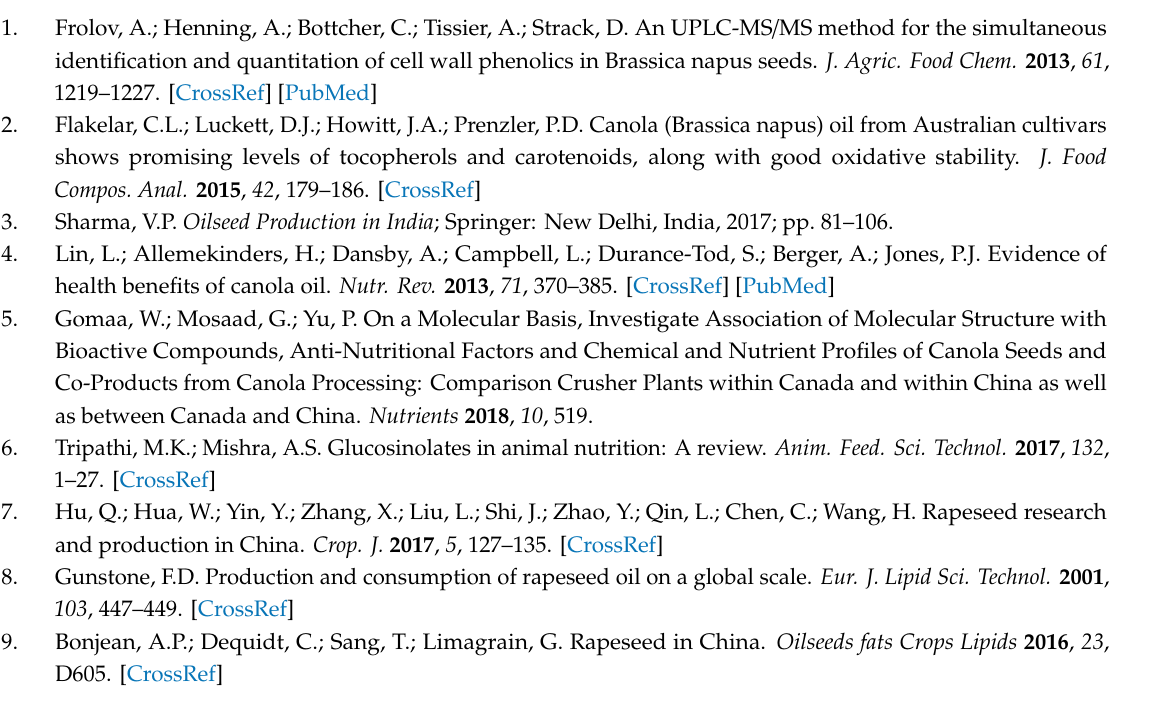
Table S1: Metabolites in rapeseed identified based on UPLC-Q-TOF / MS. Table S2: Di ff erential metabolites between Chinese and Canadian rapeseeds ( | p (corr) |> 0.8, p -value < 0.001, and FC > 2 or < 0.5)., Table S3: Di ff erential metabolites between Chinese and Mongolian rapeseeds ( | p (corr) |> 0.8, p -value < 0.001, and FC > 2 or < 0.5). Table S4: Di ff erential metabolites between Canadian and Mongolian rapeseeds ( | p (corr) |> 0.8, p -value < 0.001, and FC > 2 or <